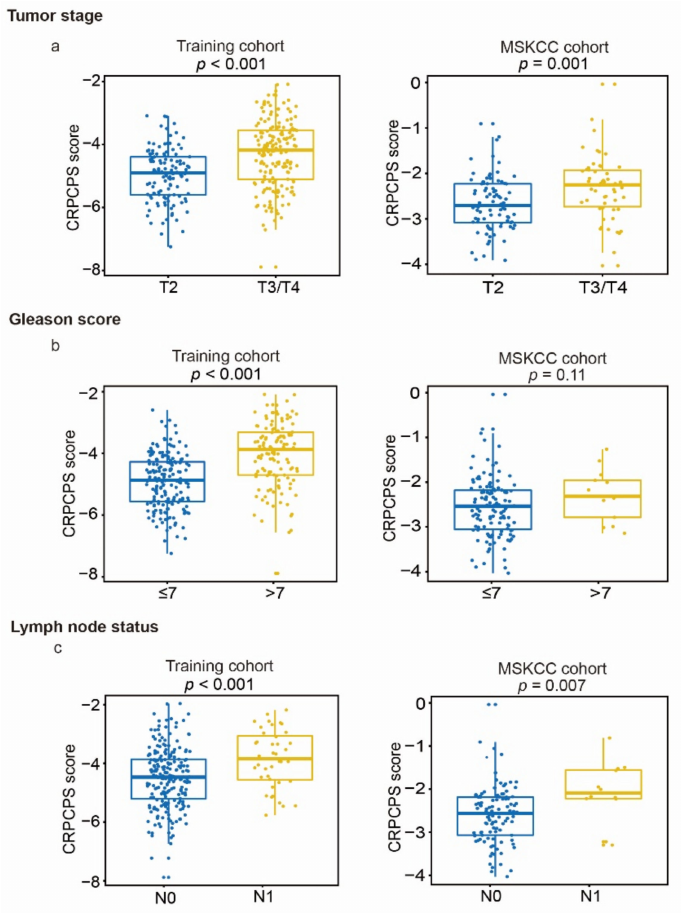
Figure 9. Associations of CRPCPS with tumor stage ( a ), Gleason score ( b ), and lymph node status ( c ) in the training cohort (left panel) and the MSKCC cohort (right